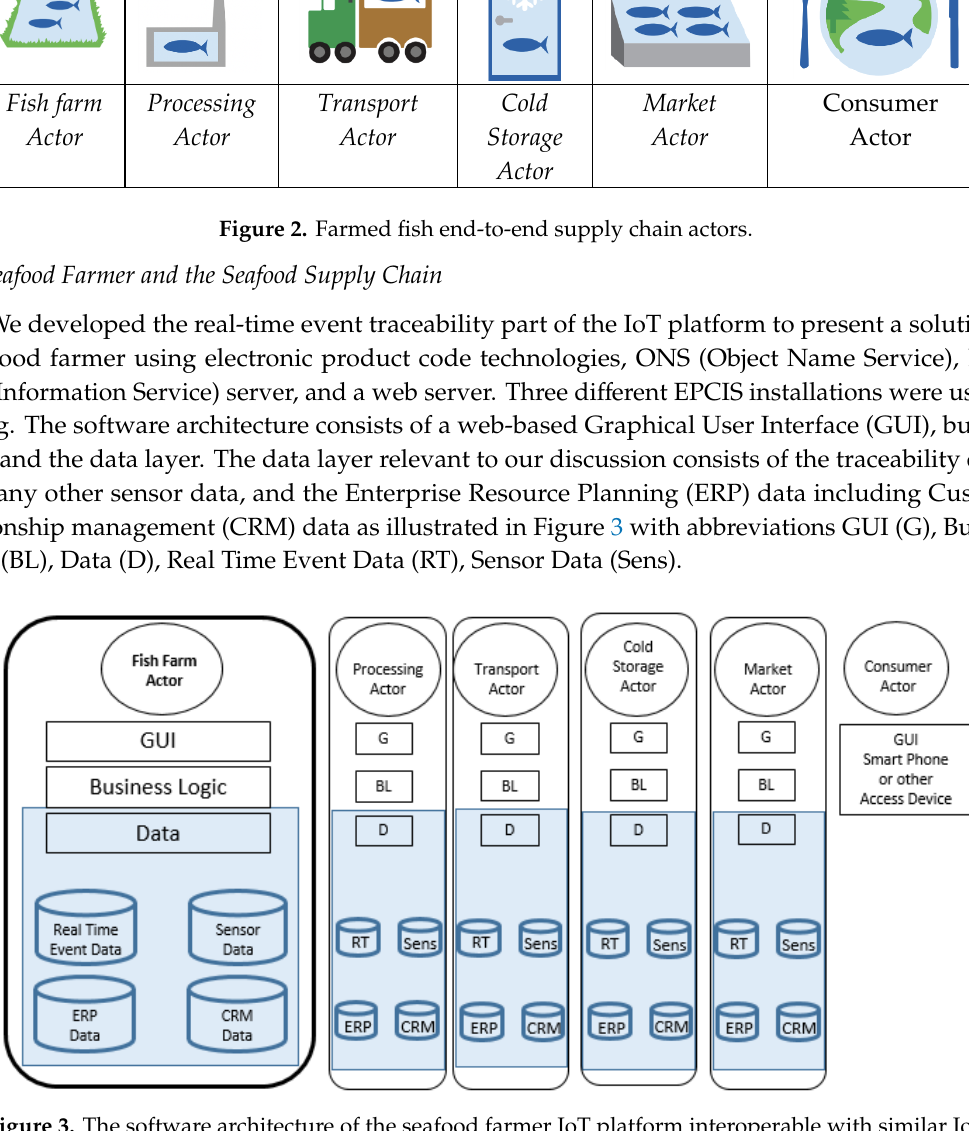
Figure 3. The software architecture of the seafood farmer IoT platform interoperable with similar IoT platforms of other supply chain actors and accessed by the consumer.